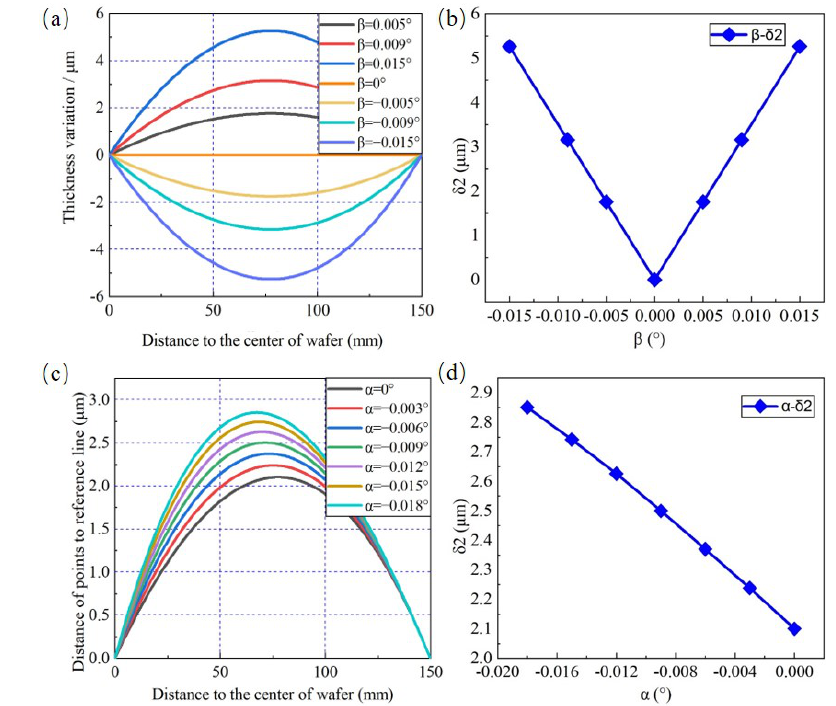
Figure 7. The change rules of δ 2 affected by space angles. Effect of ( a ) β on the thickness variation ( α = 0); ( b ) β on δ 2 ; ( c ) α on the distance of points to the reference line ( β = − 0.006°); ( d ) α on δ 2 . In order to eliminate the influence caused by β on δ 2 and only analysis the effect of α , β is set to 0° and α ranges from − 0.018° to 0°. As shown in Figure 8a,b, the values of δ 1 linearly tend to 46.9 µ m, but the values of δ 2 caused by α are lower than 1 µ m and are much smaller than the values of δ 1 . As introduced in Section 2.2, δ 2 can be calculated from the distance of all the points on the wafer section curve to the reference line shown